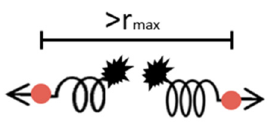
Figure 1. Particle representation and interactions among the computational particles.